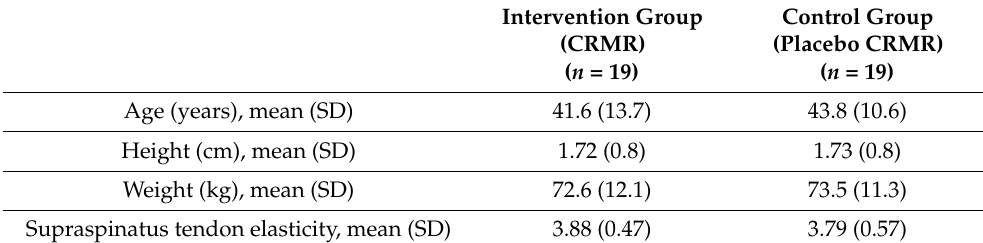
Table 1. Baseline demographic